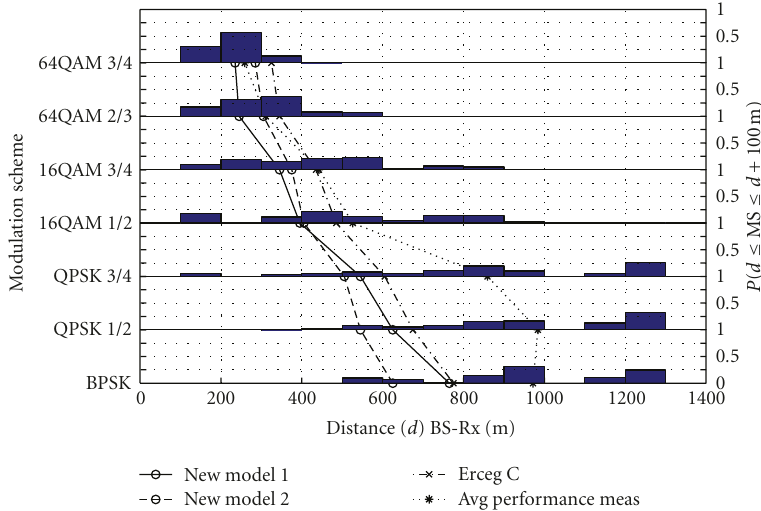
Figure 6: WiMAX modulation schemes as a function of the distance for path loss model 1, model 2, and Erceg C model compared to the average actual performance ( P ( d ≤ MS ≤ d + 100m), with d = distance BS-Rx, represents the probability ( P ) that a certain modulation scheme (MS) occurs in a zone d to d + 100m from the